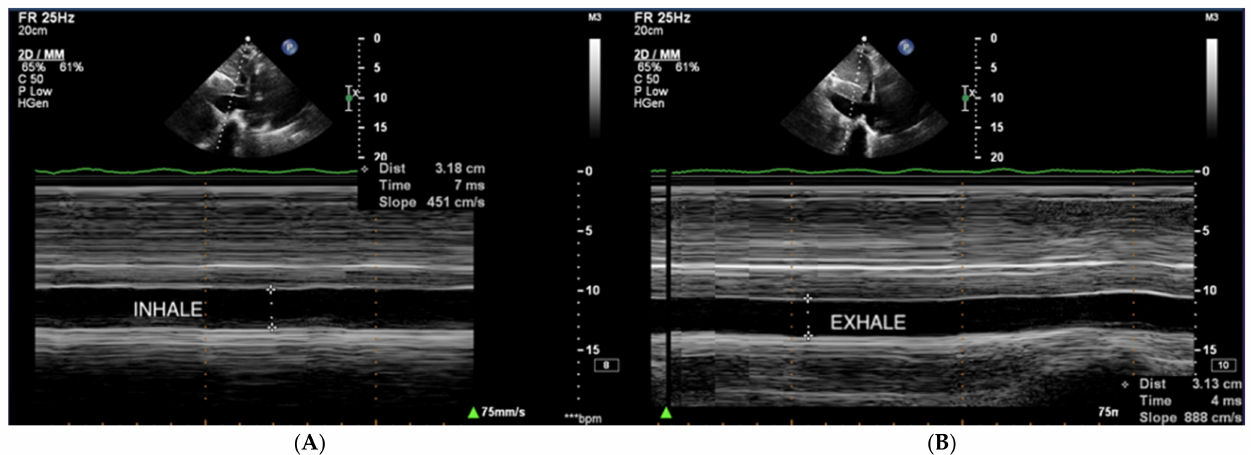
Figure 11. ( A , B ) IVC, no respiratory variability of IVC in the course of PAH. TTE, subcostal view. IVC: inferior vena cava; TTE: transthoracic echocardiography.